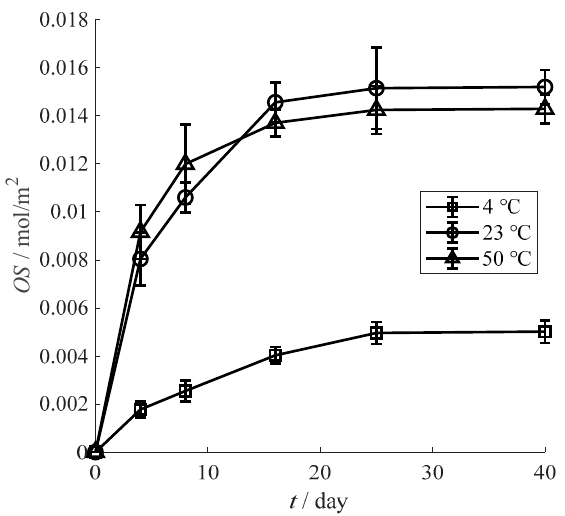
Figure 8. Influence of temperature on the oxygen scavenging performance.